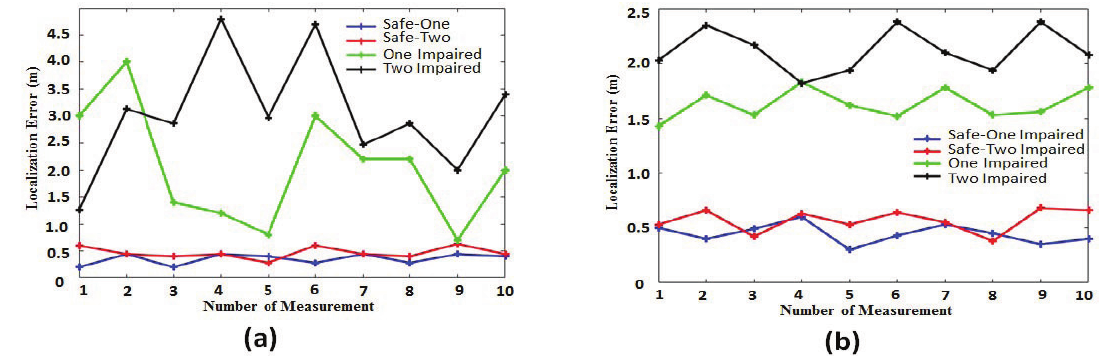
Figure 10. Error analysis of different impaired quantities. ( a ) Multiple localization with the same location. ( b ) Error mean in multiple localization of different